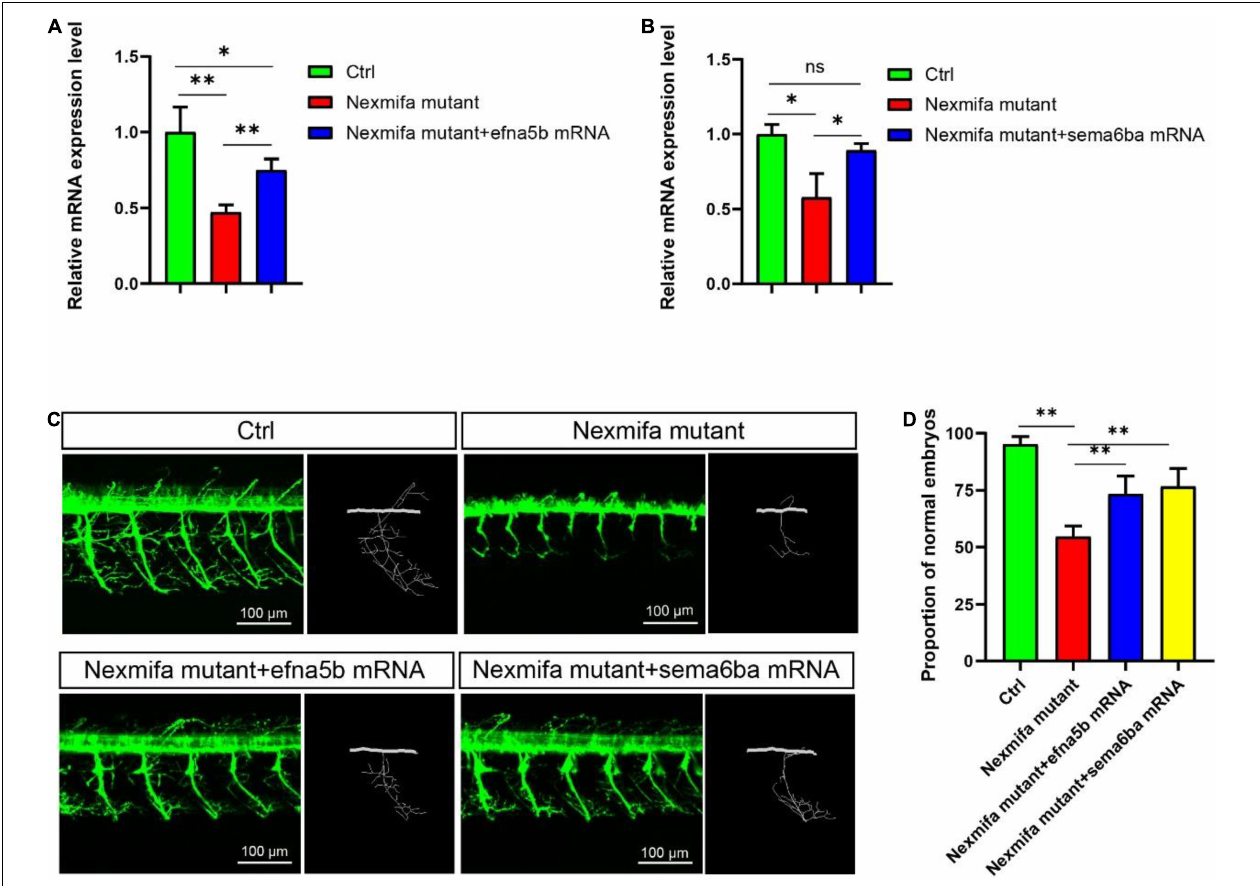
FIGURE 7 | Efna5b and sema6ba overexpression rescues motor neuron defects in nexmifa morphant embryos. (A) Expression of efna5b after injection of efna5b mRNA in nexmifa mutant embryos at 72 hpf. (B) Expression of sema6ba after injection of sema6ba mRNA in nexmifa mutant embryos at 72 hpf . (C) Abnormal PMNs in nexmifa morphant zebrafish were rescued by injecting efna5b or sema6ba mRNA. (D) Percentage of zebrafish embryos with normal Cap primary motor neurons ( n = 150, 242, 250, and 257, respectively). ∗ p < 0.05 and ∗∗ p < 0.01. ns: non-significant.